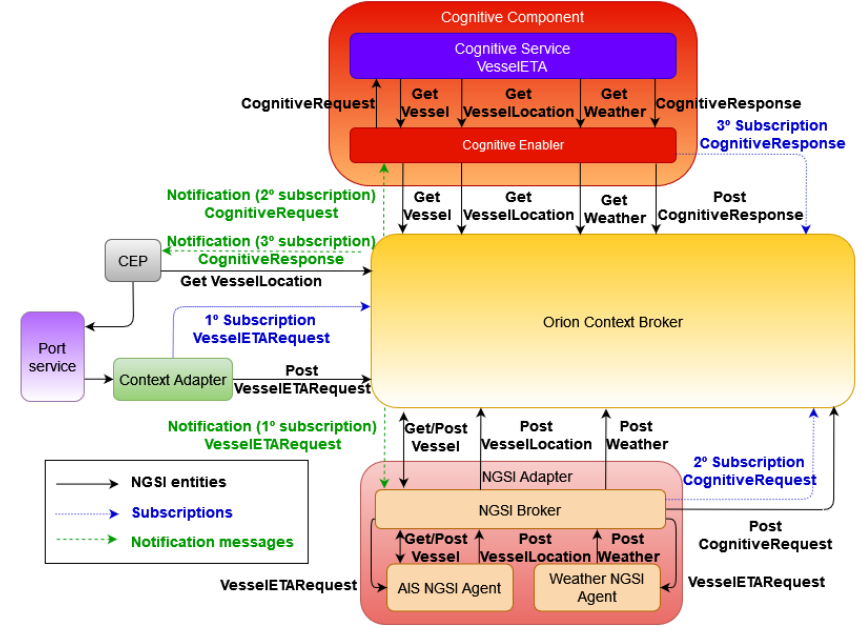
Figure 2. System architecture and messages.